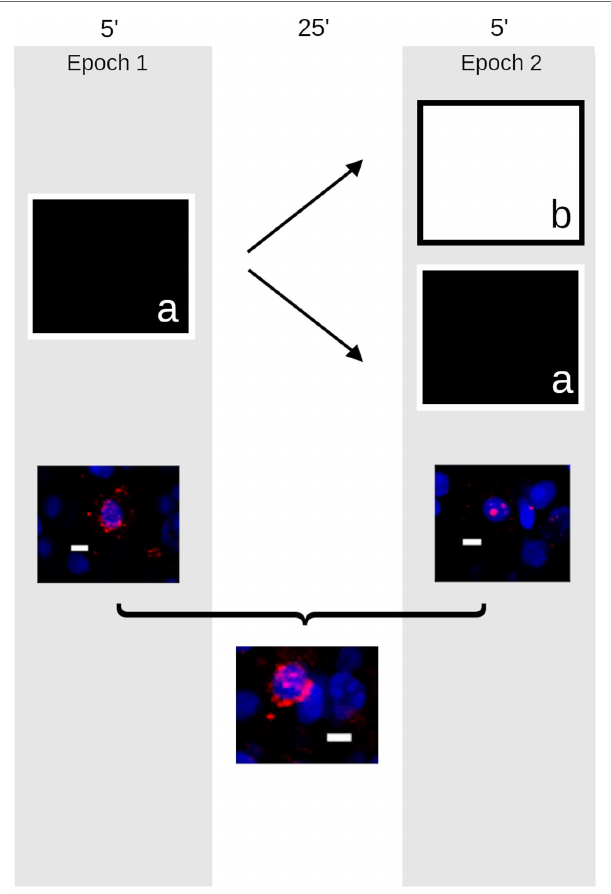
FIGURE 1 | Schematic outline of the experiment. The timeline presented above shows that quail were taken to an open field (a) approximately 1 m 2 containing distinct local and distal cues and provided passive exploration for 5 min (left). They returned to their housing room for 25 min before either being returned to the same environment (a) or placed in a new environment (b) in a different room containing a different complement of local and distal cues (right). Following these trials (below), the animals’ brains were harvested and the compartmental expression of Egr1 (red) was measured to provide a histological record of activity in neurons counterstained with DAPI (blue) in the quail hippocampus (Scale bar = 10 μ m). Cells active during the first epoch on the maze expressed Egr1 within the cytoplasm (left); those active during the second epoch express Egr1 within the nucleus (right). Cells active during both epochs express Egr1 within both cellular compartments